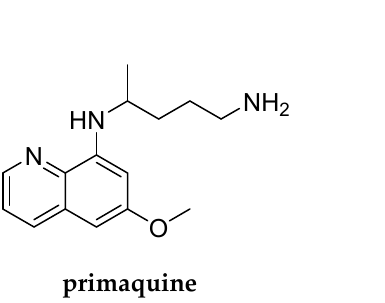
Figure 1. Structures of primaquine and tafenoquine.